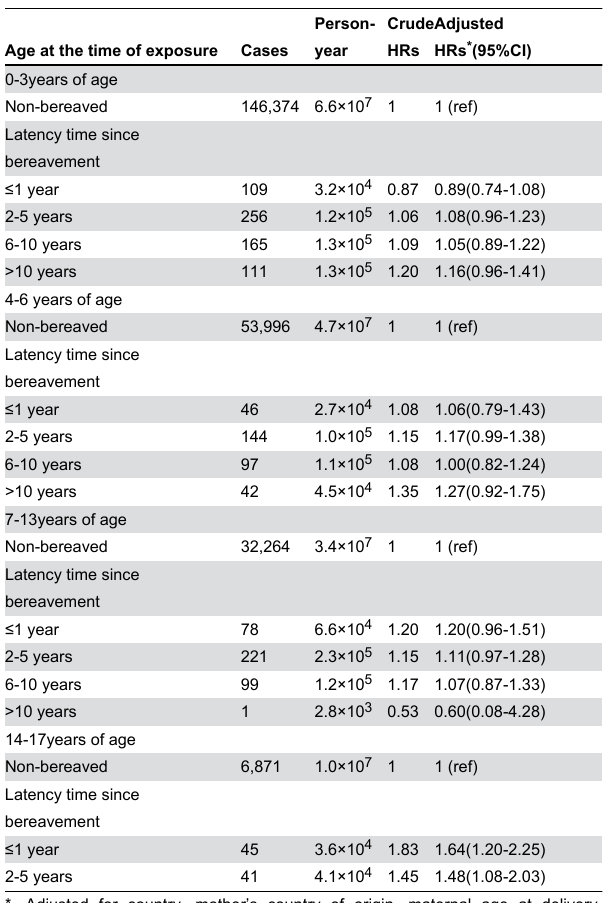
Table 3. Hazard ratios (HRs) for asthma hospitalization according to bereavement stratified on age at the time of exposure and latency time since bereavement.